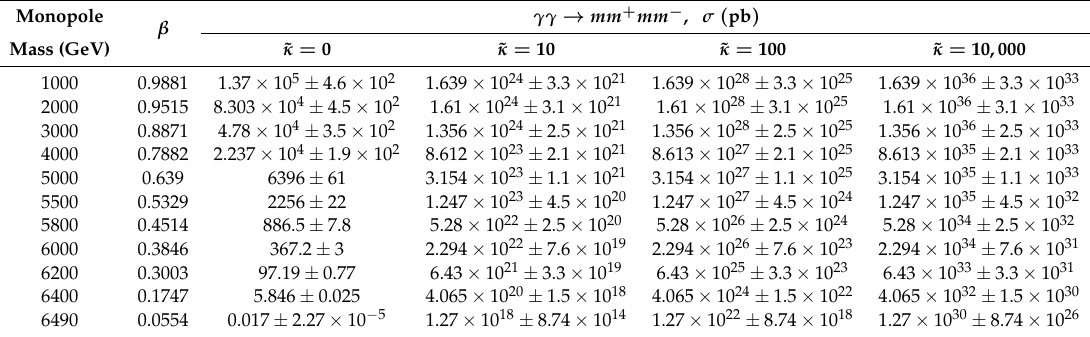
Table 7. Photon fusion production cross-sections at a photon-photon collision energy of 13 TeV for the spin 1 / 2 monopole, β -dependent coupling, and various values of the ˜ κ parameter [10]. Monopole γγ → mm + mm − , σ ( pb β